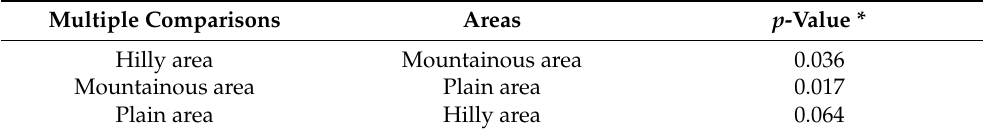
Table 4. Significance of multiple comparisons (by ANOVA) for provisioning service perceptions in three topographic